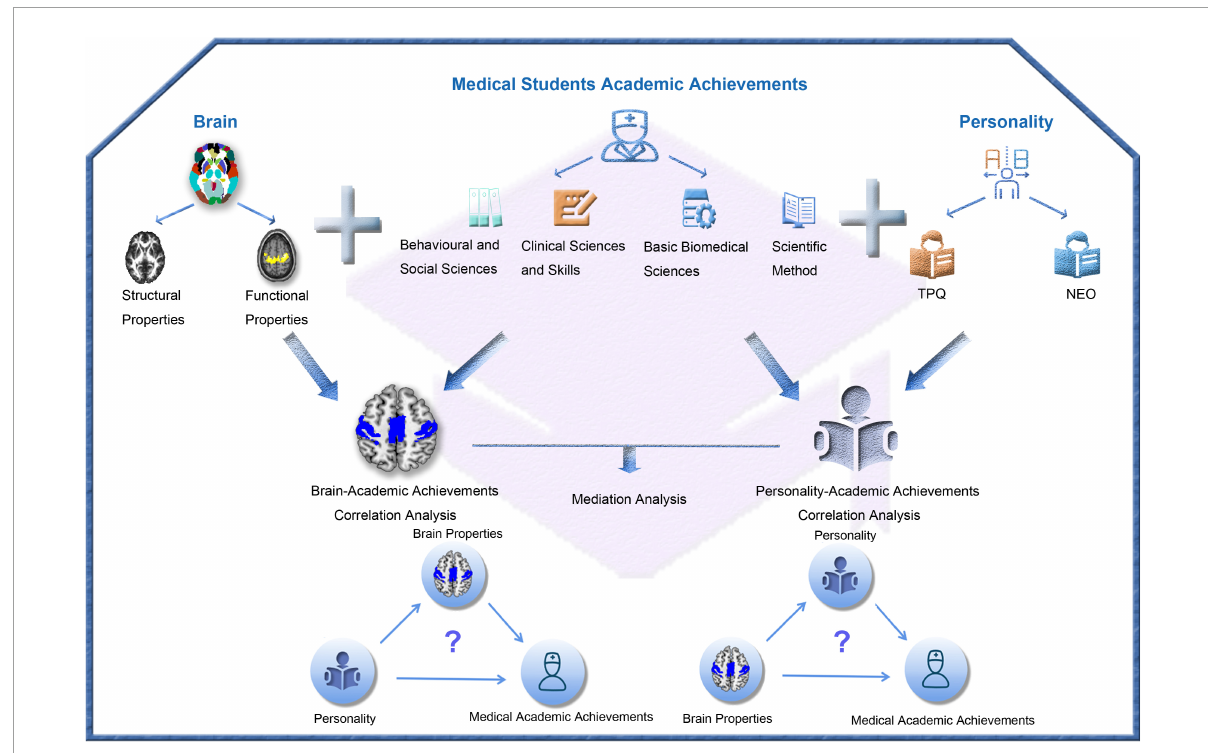
FIGURE1 Flowchart of the study design. TPQ, tridimensional personality questionnaire; NEO, neuroticism Extraversion openness personality